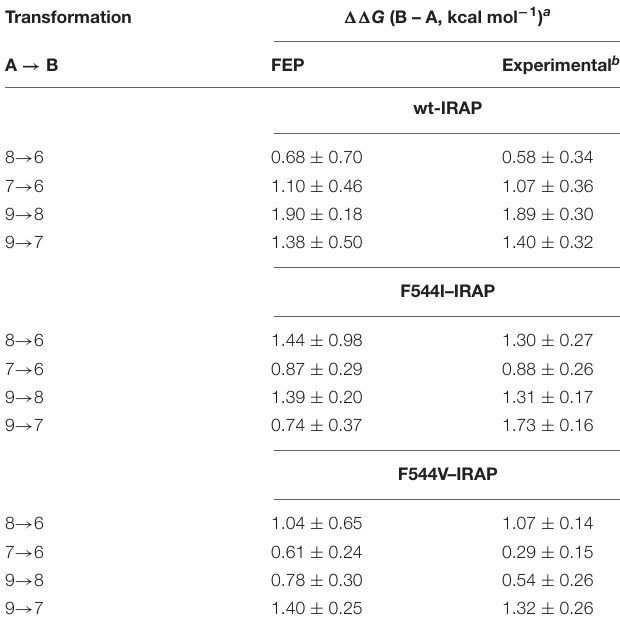
TABLE 3 | Experimental and FEP calculated relative binding free energies between ligand within the subset of compounds 6–9, both in wild type and mutant versions of